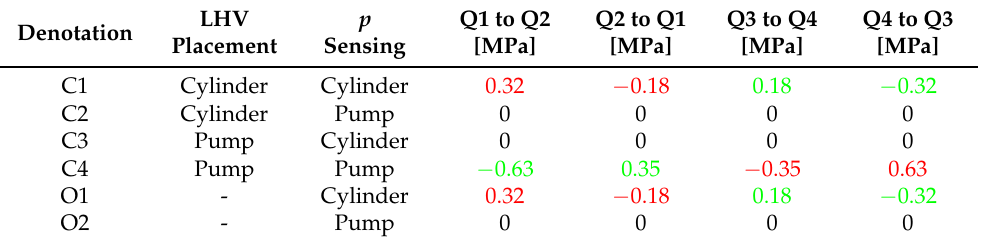
Table 2. Change in static pressure difference for different configurations when switching between different modes. Green colour corresponds to positive hysteresis and red to